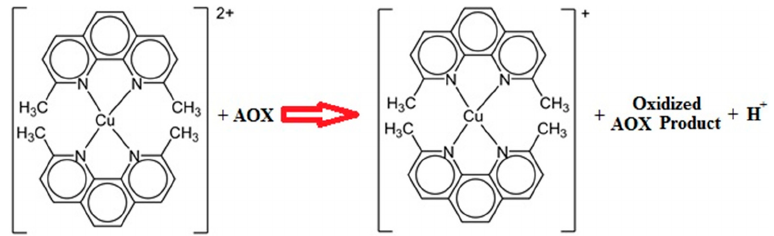
Figure 1. The CUPRAC reaction of Cu(II)-neocuproine complex with antioxidants, producing the yellow-orange colored Cu(I)-neocuproine chelate ( λ max = 450 nm).